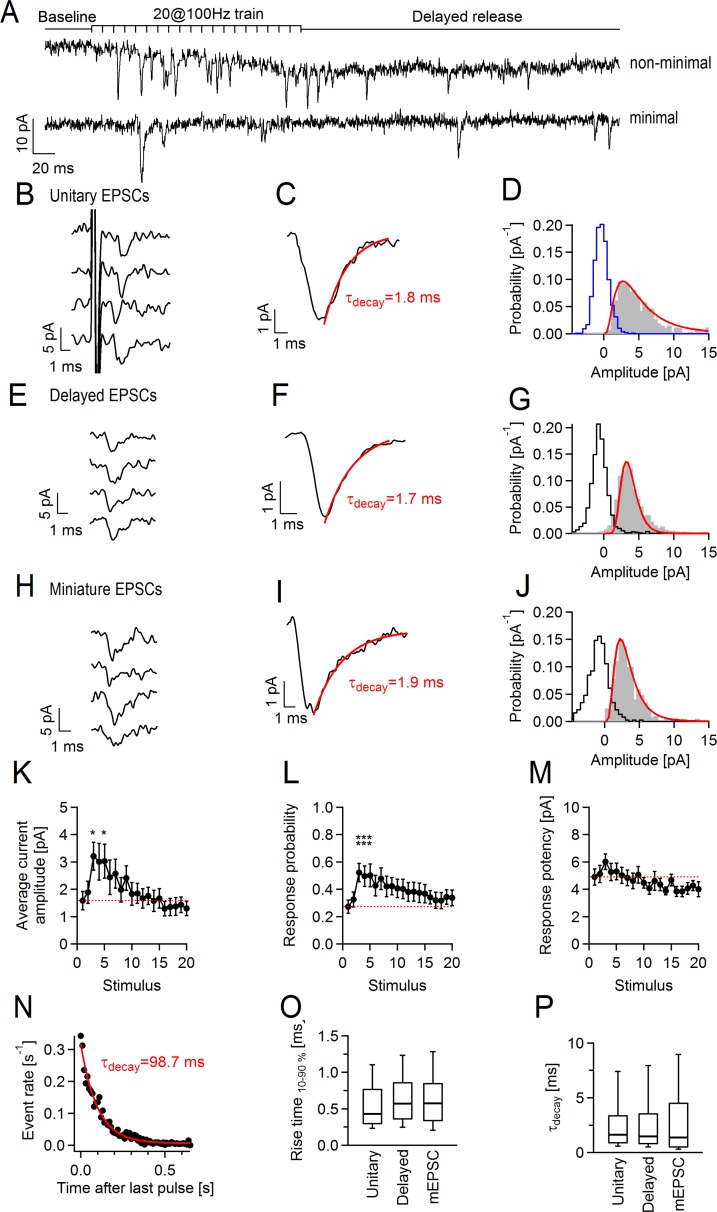
Phasic and delayed currents occur in callosal oligodendrocyte precursor cells (OPCs) upon train stimulation of callosal axons with 20 pulses at 100 Hz.(A) Representative example traces showing phasic and delayed currents in OPCs (holding potential [Vh] = −80 mV) upon nonminimal (top) and minimal (bottom) stimulation of callosal axons. (B–J) Unitary, delayed, and miniature excitatory postsynaptic currents (EPSCs) in OPCs. (B, E, H) Original example events. (C, F, I) Average current waveforms generated by averaging of (C) 34 unitary events without failures, (F) 170 delayed events, and (I) 106 miniature events. Red lines indicate monoexponential fits to the decaying phase of the current. (D, G, J) Amplitude distribution histograms fitted with lognormal function (red line). Total of (D) 265 unitary events from 20 OPCs, (G) 2,089 delayed events from 14 OPCs, and (J) 370 miniature events from 4 OPCs were pooled for each histogram. Blue empty histogram in (D) represents amplitude distribution histogram of 894 failures pooled from the same 20 OPCs that were used for the histogram of responses. Black empty histograms in (G, J) indicate noise distribution. (K–M) Average current amplitude including failures, response probability, and response potency during minimal stimulation train. Each point represents the mean value from 14 cells for a given stimulus. To ease visualization of facilitation, a dashed red line is drawn at the level corresponding to the value at the first stimulus. One-way ANOVA with post hoc Dunnett’s test was used to compare the values for each stimulus to the value measured at the first stimulus (S1 Table). Each point represents mean ± SEM. (N) Average rate of delayed events after the minimal stimulation train. 1,702 events from 14 cells were pooled for this histogram. Red line indicates monoexponential fit to the events rate. (O–P) Rise time and decay time constants of unitary, delayed, and miniature EPSCs (mEPSCs) in OPCs. The values were measured on the same events used for the amplitude distribution histograms in (D, G, J). One-way ANOVA (S1 Data). *p < 0.05, **0.001 < p < 0.01, ***p < 0.001. Box and whisker plots: the bottom and top of each box represent 25th and 75th percentiles of the data, respectively, while whiskers represent 10th and 90th percentiles. The midline represents the median. The numerical data used in K–M and O–P are included in S2 Data.